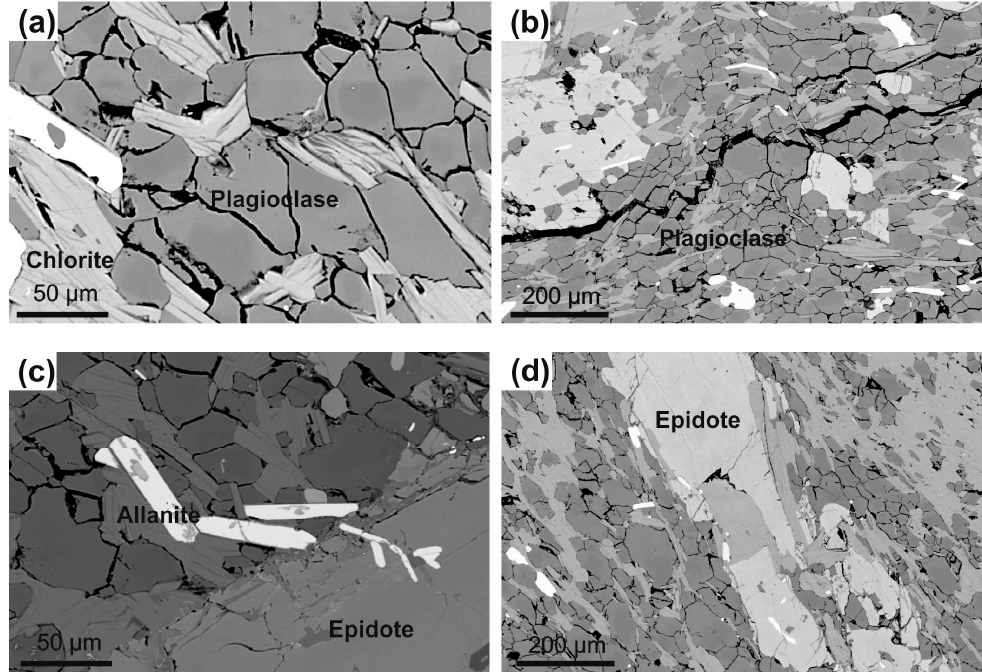
Figure 4. Backscattered-Electron (BSE) micrographs of the studied samples from the Aravalli area. ( a ) retrogressive Mg chlorite with plagioclase grains, ( b ) euhedral plagioclase grains, ( c , d ) accessory allanite and epidote after